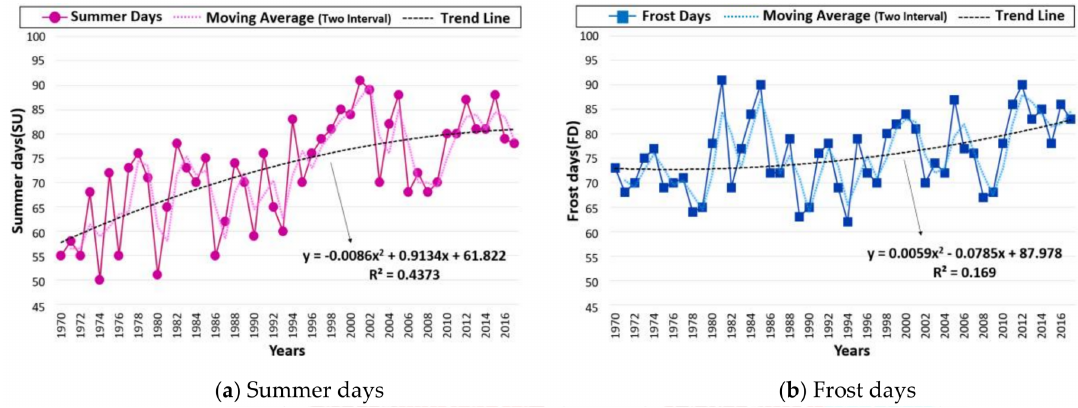
Figure 3. Frequency analysis on the number of summer days and frost days in